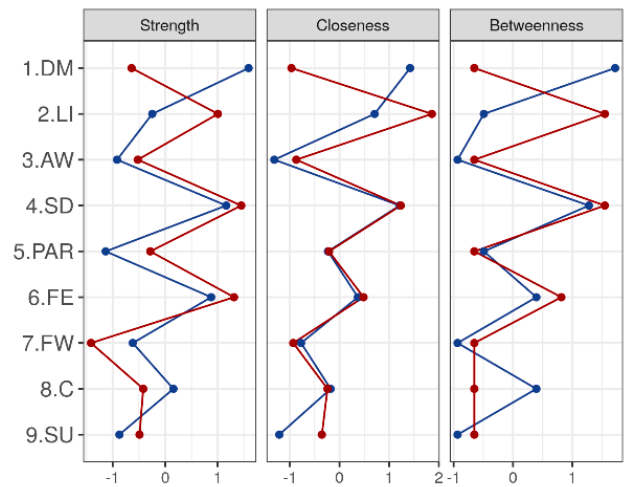
Figure 1. Centrality measures for CIDI65 + items by gender groups. DM: depressed mood; LI: loss of interestorpleasure; AW:appetiteorweightdisturbance; SD:sleepdi ffi culties(insomniaorhypersomnia); PAR: psychomotor agitation or retardation; FE: fatigue or loss of energy; FW: feelings of worthlessness or guilt; C: diminished ability to think or concentrate; SU: suicidality; measures of centrality on CIDI65 + for women and men. The figure shows a plot of standardized values. Women are represented by the Int. J. Environ. Res. Public Health 2020 , 17 , x red line, and men by the blue line.